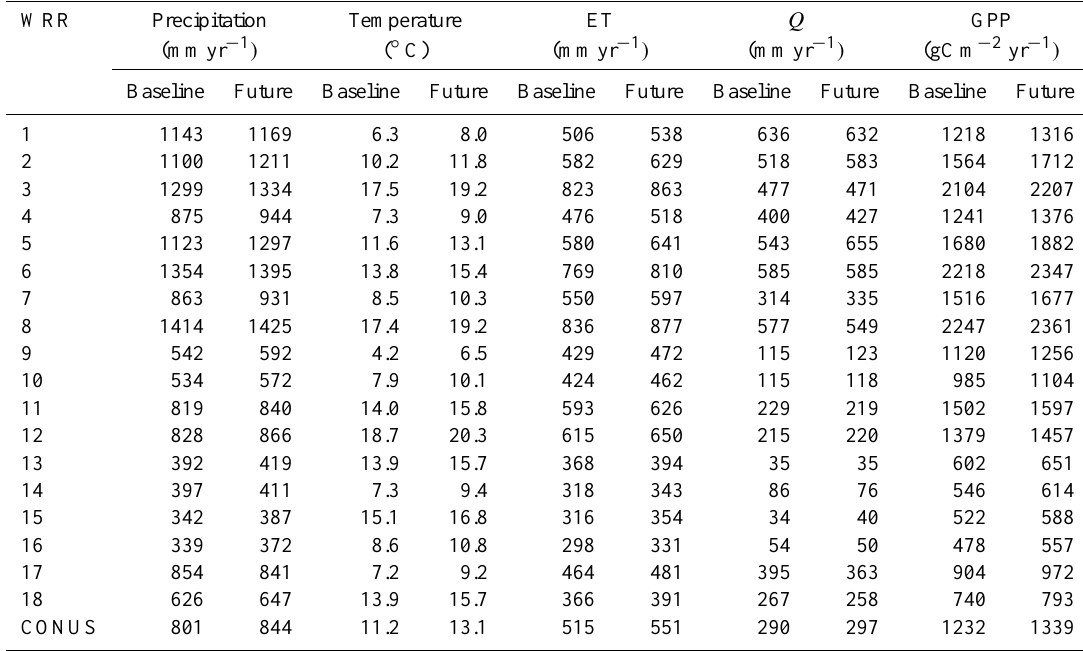
Figure 4. Spatial distribution of GPP during the baseline and the future periods, and climate change impacts (future – baseline). Table 1. Multi-year mean precipitation, temperature, ET, Q , and GPP averaged over each WRR or the entire CONUS during the baseline (1979–2007) and the future period